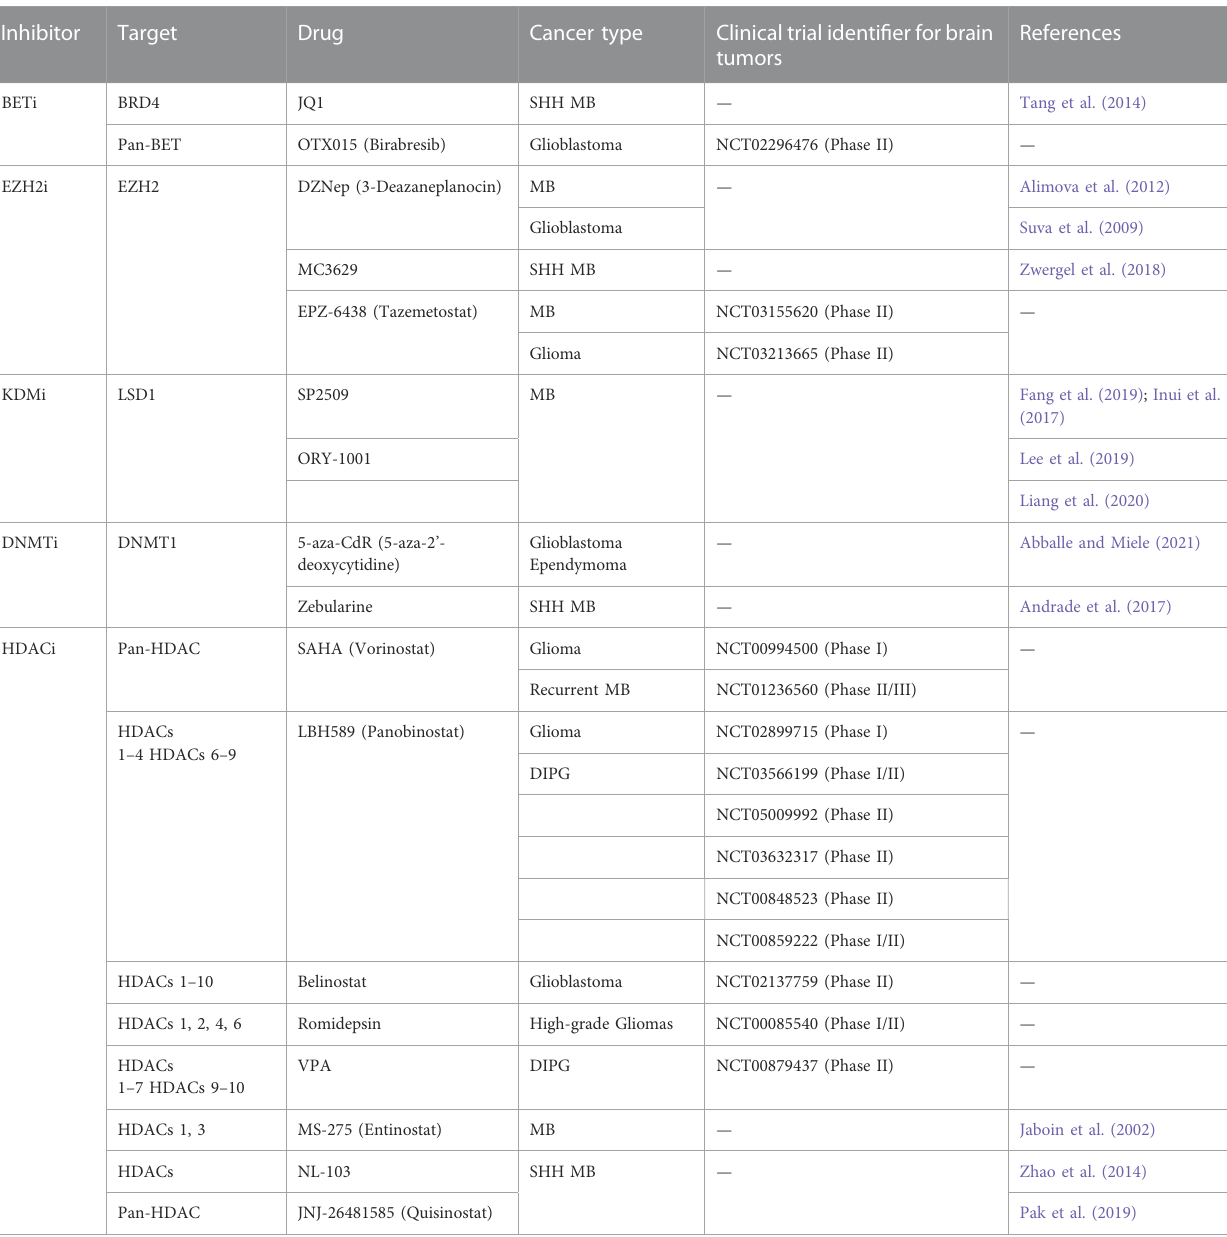
TABLE 1 Classi fi cation of epigenetic drugs in preclinical or clinical trials for brain cancer.